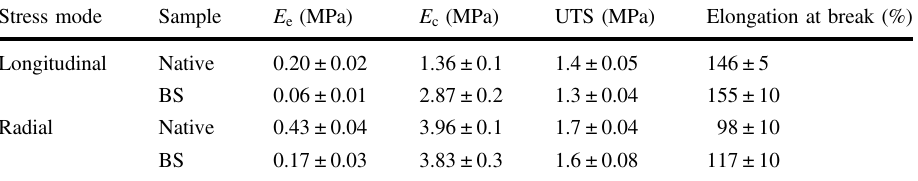
Table 1 Mechanical properties of native blood vessel and biological